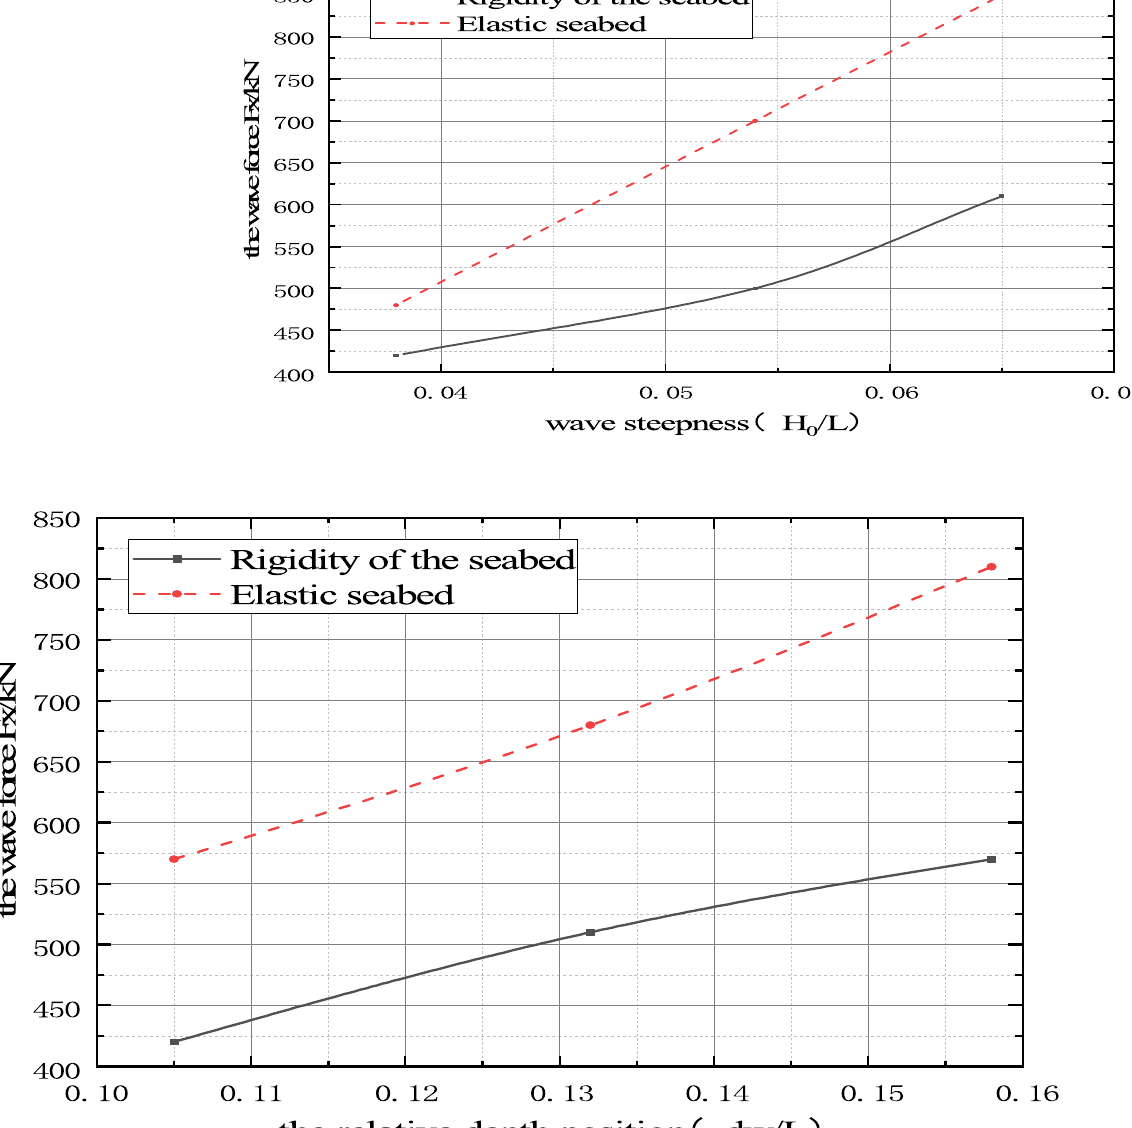
Fig. 6 Under different wave steepness ( H curve